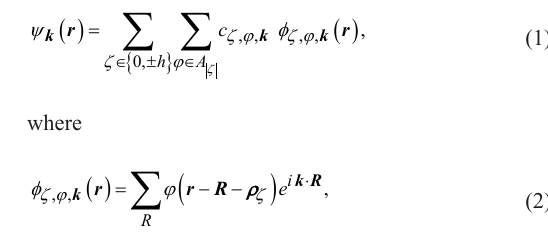
Figure 2. The first Brillouin zone of the MoS points Γ, Κ, M as well as the lines along generic points Λ, Τ, Σ are symmetry elements of the reciprocal